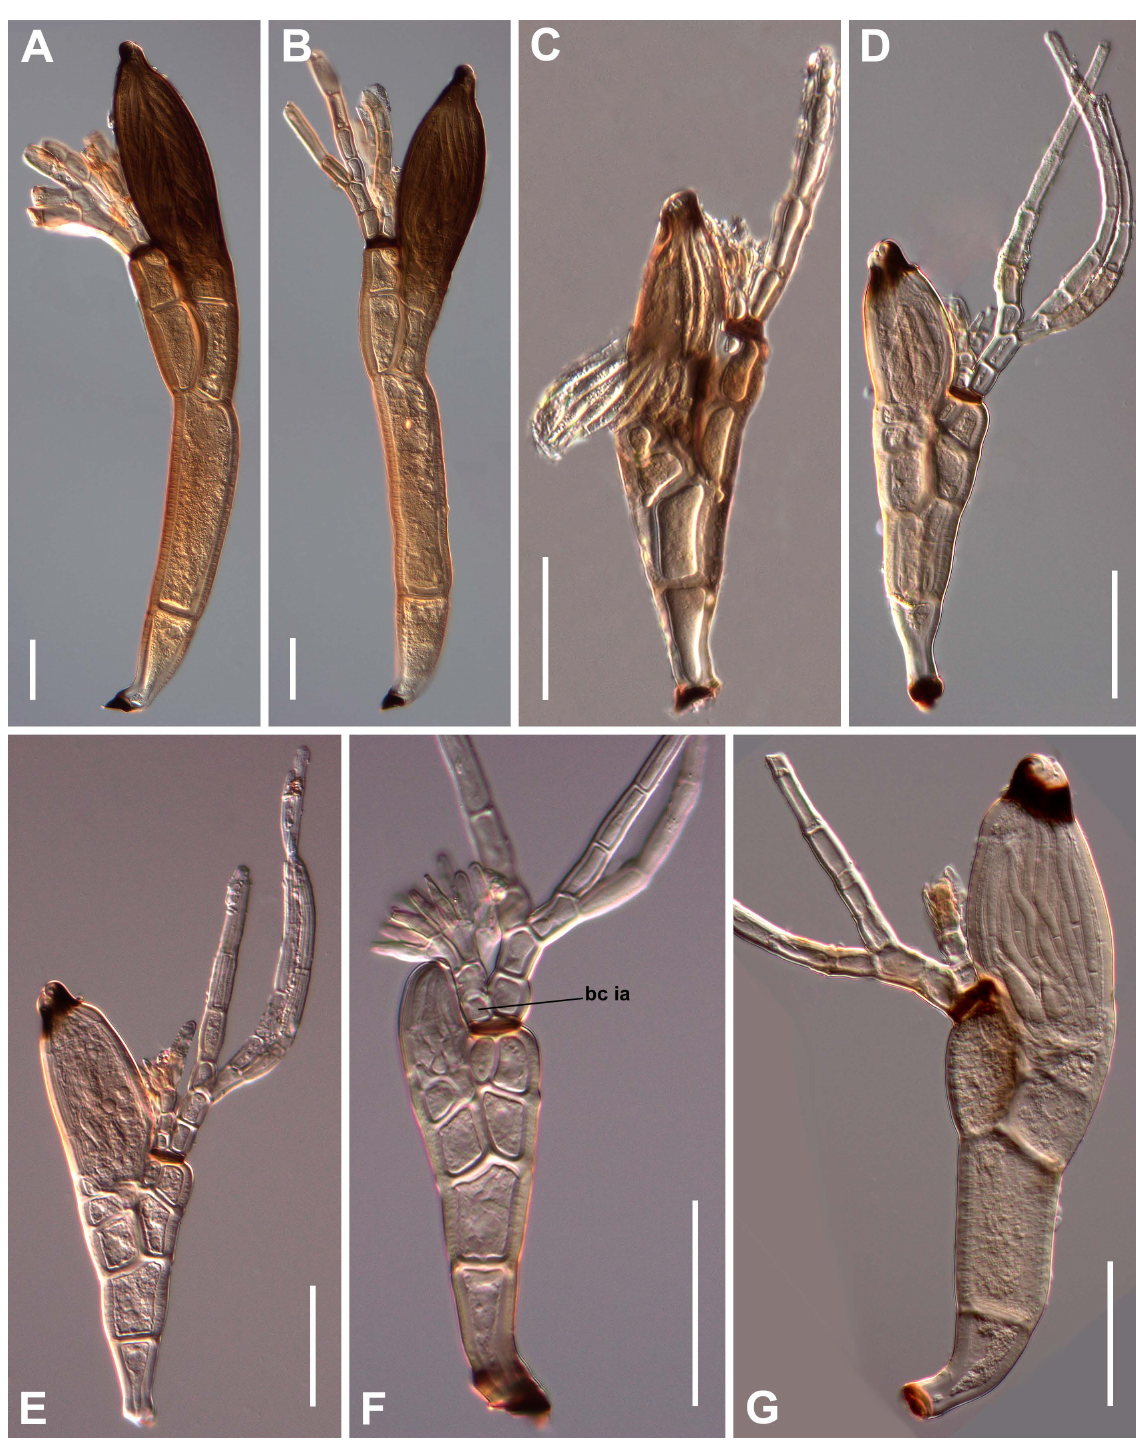
Fig. 39. Laboulbenia spp. A – B . L. oodiphila Huldén. Mature thalli. – C . L. polyphaga Thaxt. Broken mature thallus from type slide kept in FH, collected on Olisthopus parmatus . – D – G . L. ophoni Thaxt. D – E . Mature thalli from Harpalus and Ophonus , respectively. F . Immature thallus showing appendages in detail and labelled basal cell of inner appendage (bc ia). G . Mature thallus from Amara apricaria . Scale bars: 50 µm. Photographs from slides ZMUC C-F-124118 (A–B), FH8460 (C) (lectotype), ZMUC C-F-122500 (D), ZMUC C-F-124115 (E–F), ZMUC C-F-122776